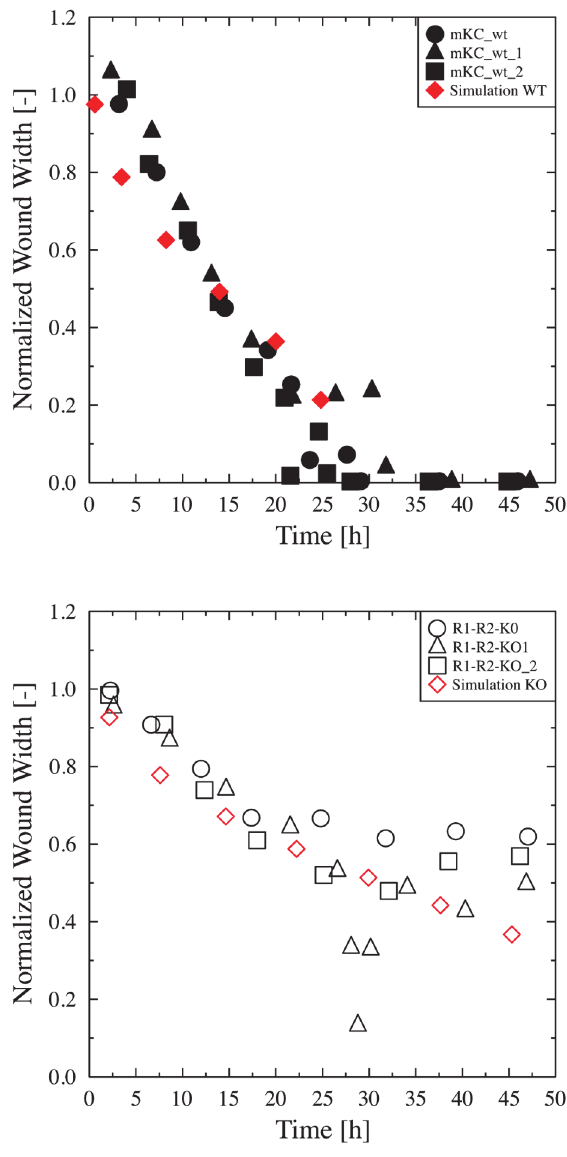
(cid:2) ¼ W ð t Þ = W ð 0 Þ for (a) the ctr cells ( (cid:5) ) and (b) the ko